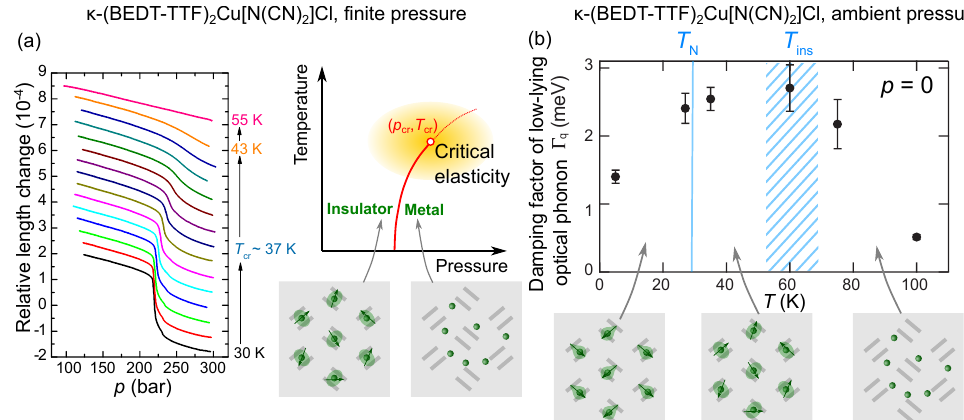
Figure 8. Coupling of correlated π -electrons with the crystal lattice in κ -(BEDT-TTF) 2 Cu[N(CN) 2 ]Cl. ( a ) Strain–stress relationships across the pressure-induced Mott metal–insulator transition [9]: The rel- ative length-change data on the left as a function of hydrostatic pressure indicate a wide temperature region above the critical endpoint located at T cr ∼ 37K, in which strongly non-linear strain–stress relationships are observed. This result implies that the crystal lattice itself becomes soft as the elec- tronic degrees of freedom become critical. This effect has been termed “critical elasticity” [131,132] and prevails in an extended region around the endpoint (right panel); ( b ) ambient-pressure study of the damping factor of a low-lying optical phonon, likely related to the BEDT-TTF breathing mode, as a function of temperature [129]. The damping factor is inversely proportional to the phonon life- time. Three characteristic regimes were identified in the data: (i) low damping at high temperatures ( T > T ins ) before the charge gap opens, (ii) high damping when the charges localize on the dimer ( T N < T < T ins ) and (iii) low damping below the onset of spin and charge order ( T < T N ). Figures adapted from Refs.